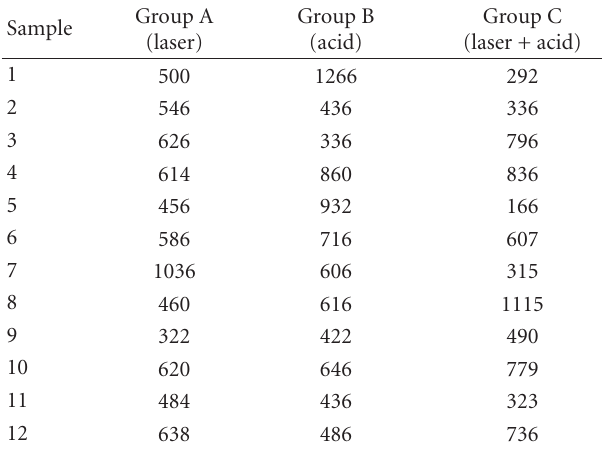
Table 2: Forces recorded by the traction test to obtain the detachment of the